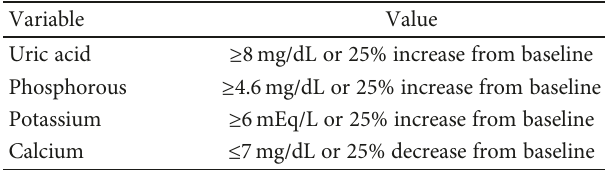
Table 2: Cairo-Bishop de fi nition of laboratory tumor lysis